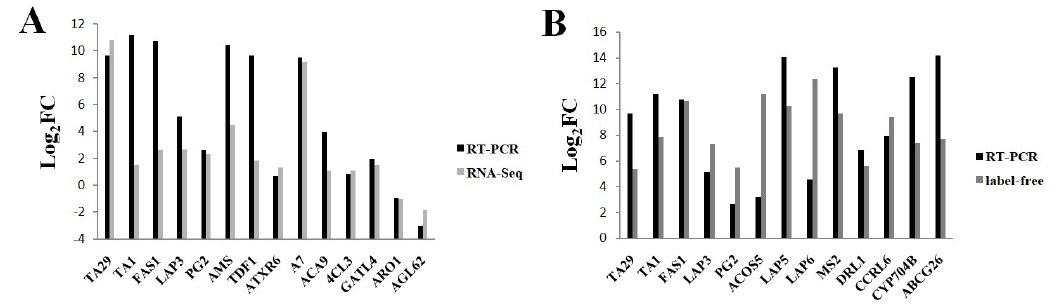
Figure 6. Validation of transcriptome and proteome data using qRT-PCR. ( A ) Relative mRNA abundance of genes selected from the DEGs; ( B ) Relative mRNA abundance of genes selected form the DEPs. Y-axis means the log 2 (16C1369B/16C1369A) of a gene or protein.